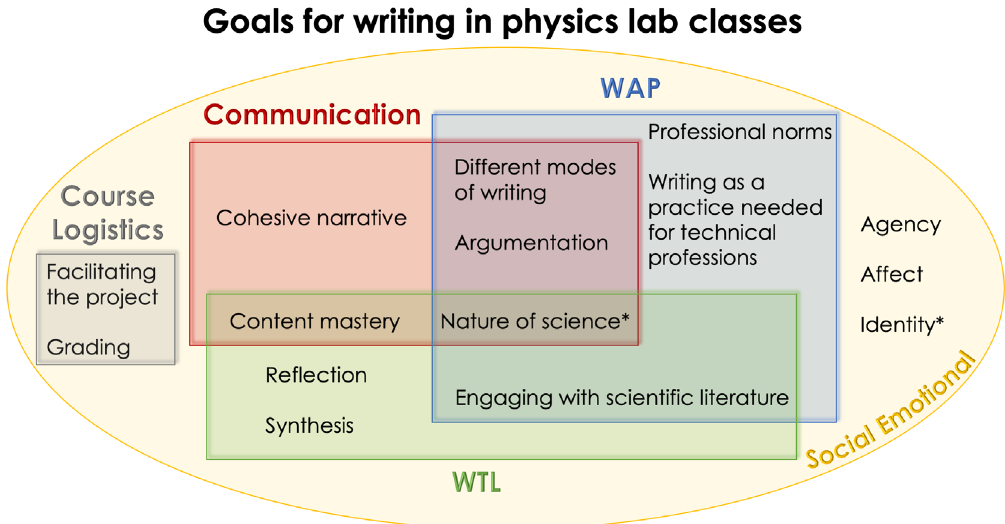
FIG. 1. Framework for thinking about and understanding the role of writing in physics lab classes. There are fifteen goals organized into five overlapping categories. Writing as professionalization (WAP). Writing to learn (WTL). *The nature of science and identity goals did not appear in our data, but we identified them as important goals for the community of physics educators and thus added them to the